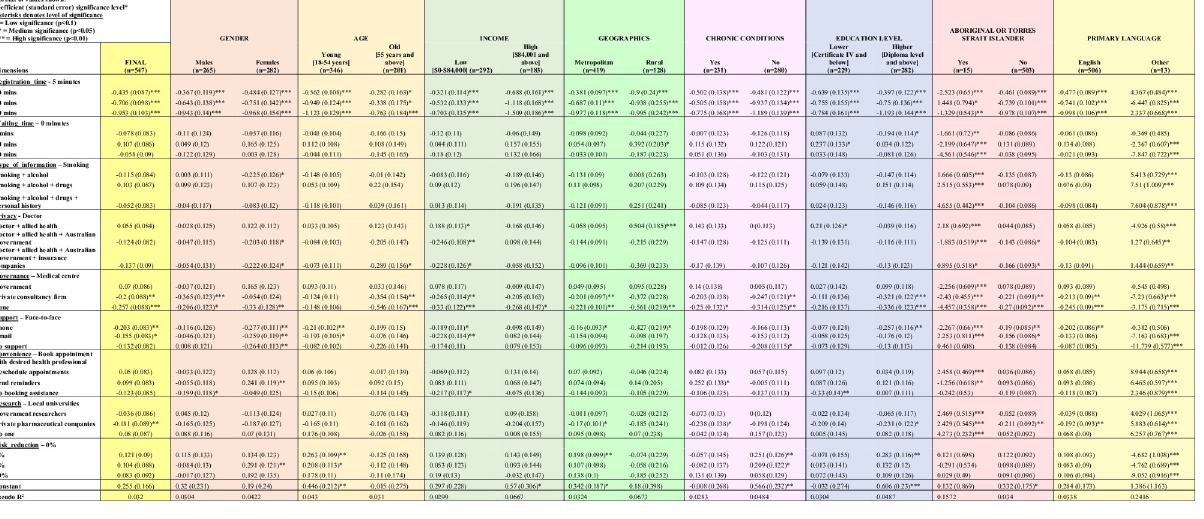
Fig 2. Data analysis and evaluation.